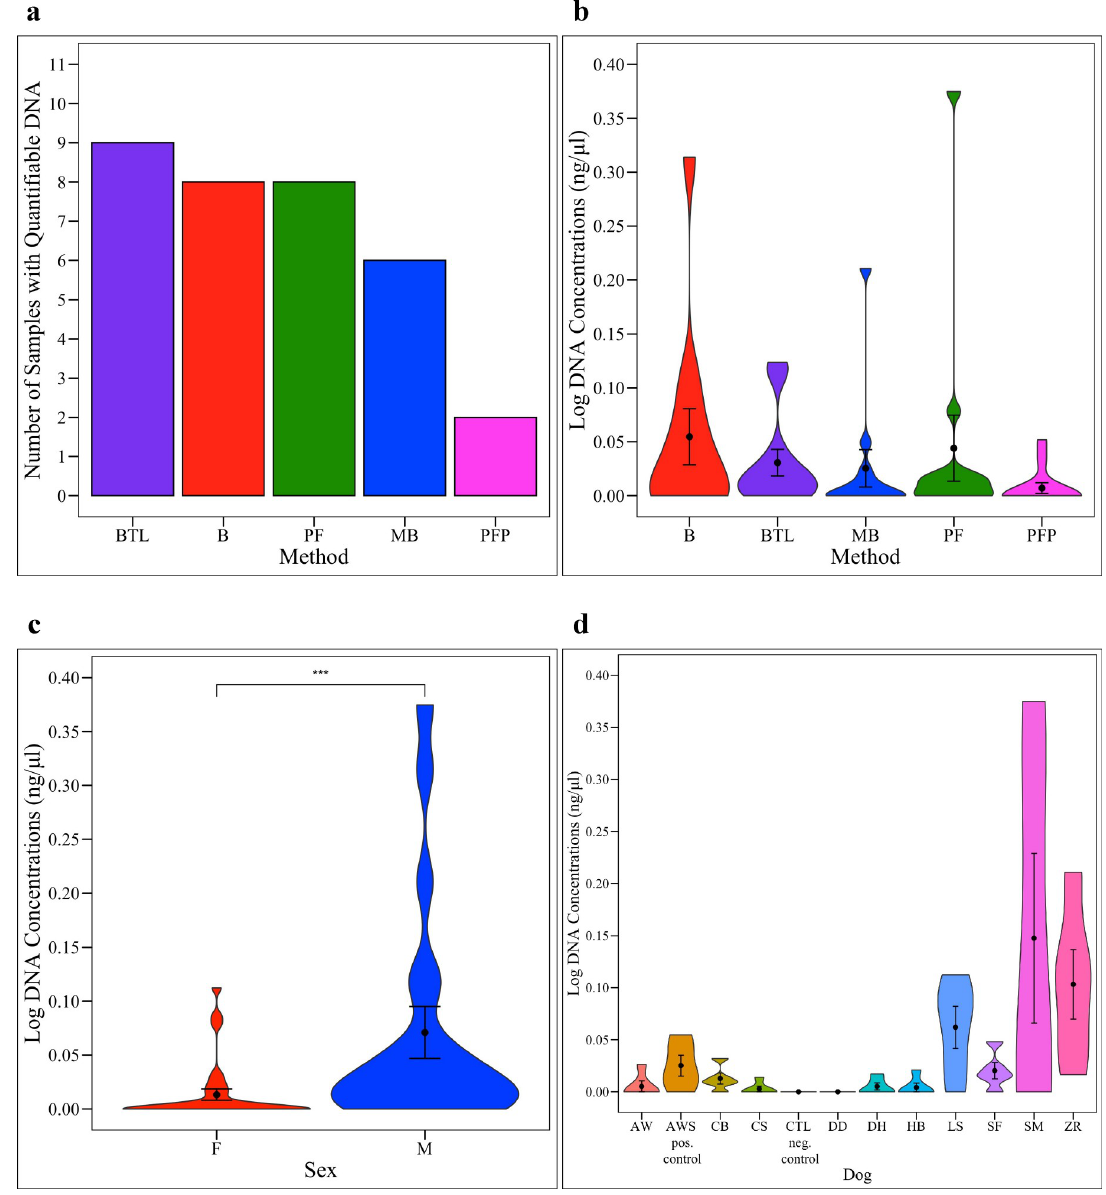
Fig 1. Total DNA concentrations. ( a ) Number of samples with measurable total DNA by extraction method (negative control excluded). Total DNA concentration, measured via Qubit, by ( b ) extraction method, ( c ) sex, and ( d ) dog. Total DNA concentrations did not differ significantly by extraction method (Kruskal-Wallis, p = 0.165) but did differ significantly by sex (Kruskal-Wallis, p = 0.0007; males > females), and dog (Kruskal-Wallis, p = 0.001). By dog, no pairwise comparisons were statistically significant. B = Bacteremia, BTL = Blood & Tissue with Lysozyme, MB = Magnetic Beads, PF = PowerFecal 1 , PFP = PowerFecal 1 Pro, F = Female, M =